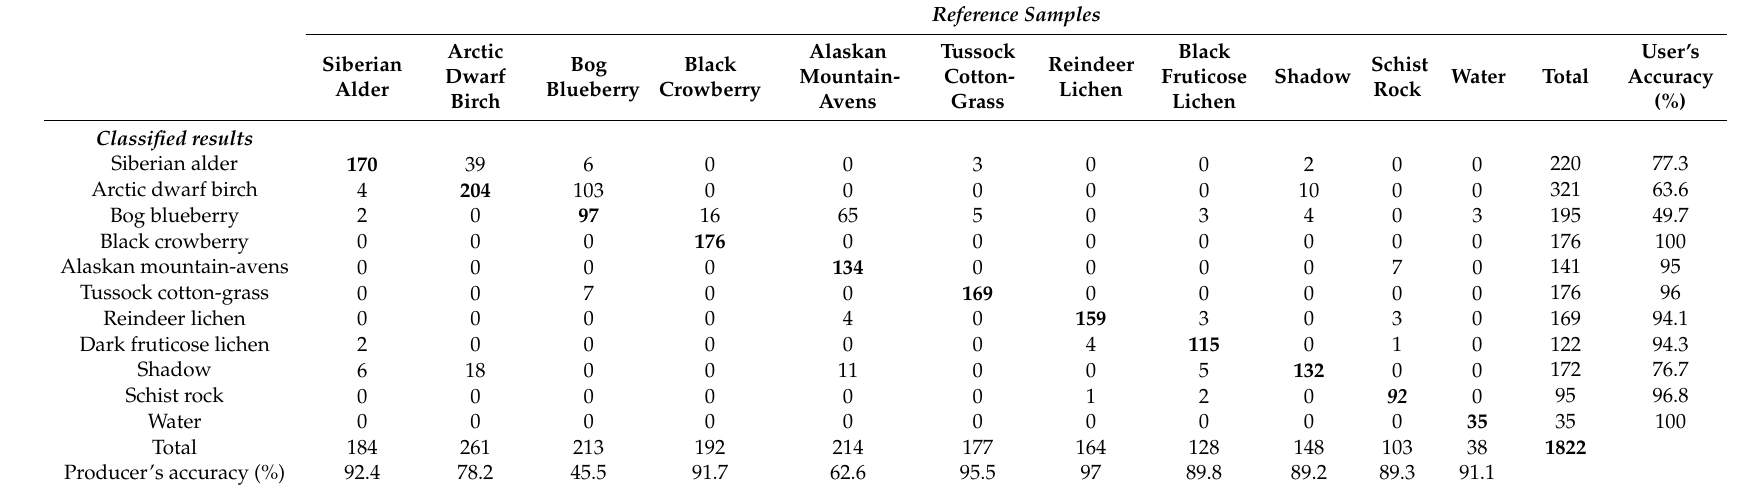
Table 3. Confusion matrix for species-level classification accuracy assessment. The diagonal cells (highlighted by bold text) correspond to reference samples that were correctly